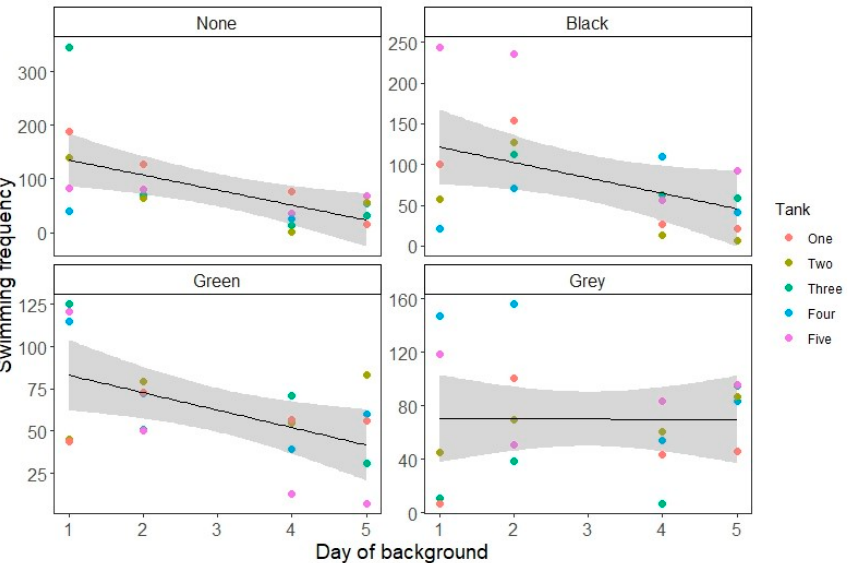
Figure 1. Swimming count over time for each tank background, presented as swimming count for each tank on each day of the observation period. The grey area represents the standard error of the estimate.